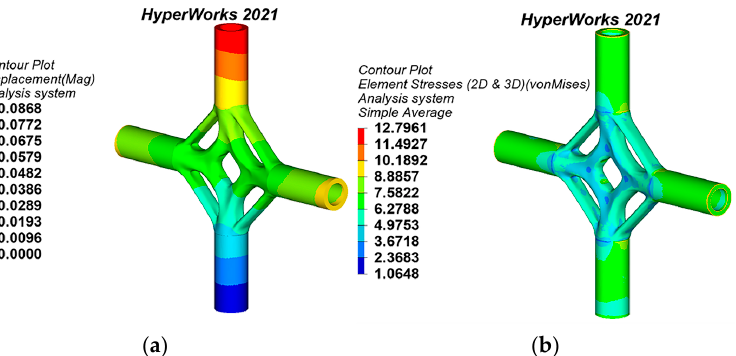
Figure 7. Static analysis results of generative joint 1: ( a ) displacement nephogram, ( b ) equivalent stress nephogram.